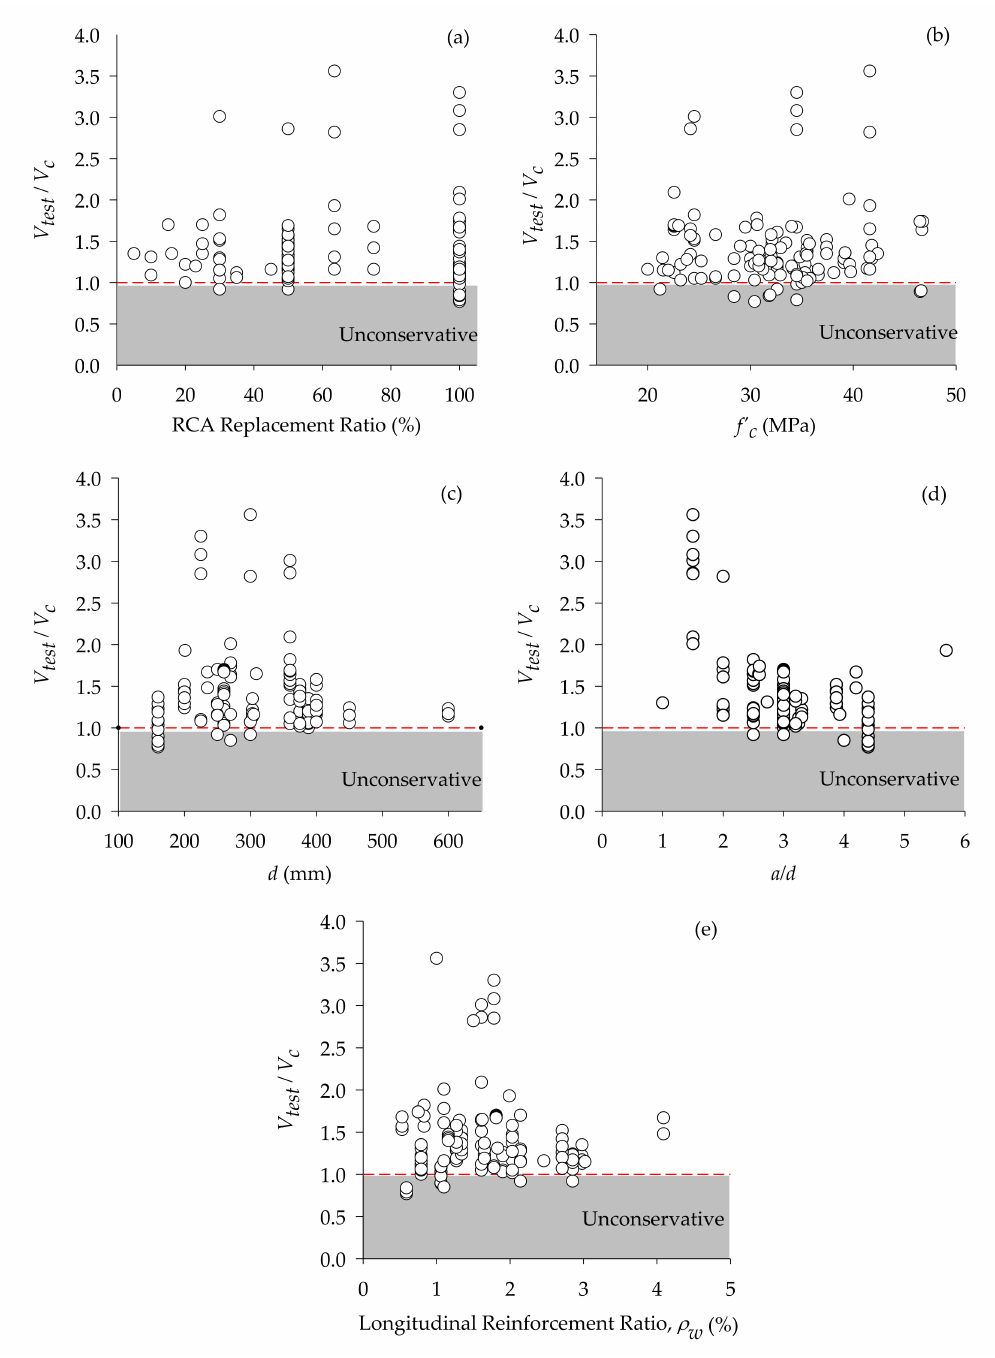
Figure 10. Comparison between V test /V c using ACI 318-19 shear provisions for different